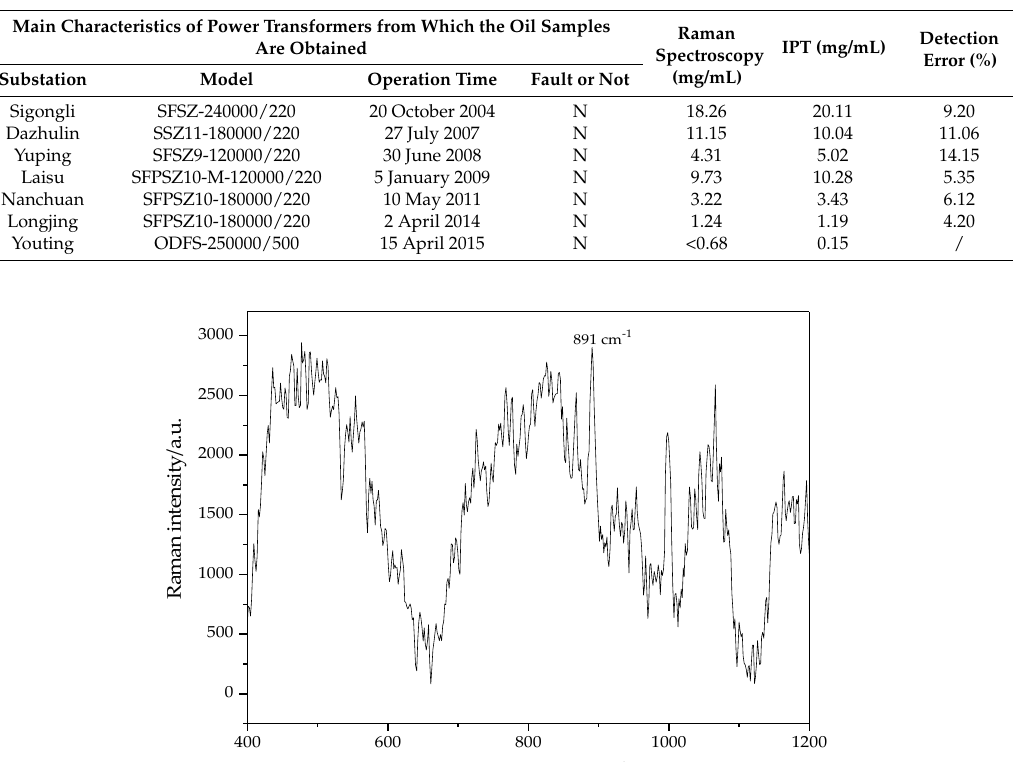
Table 2. Dissolved acetic acid detected by Raman spectroscopy and indicator-potentiometric titration (IPT).